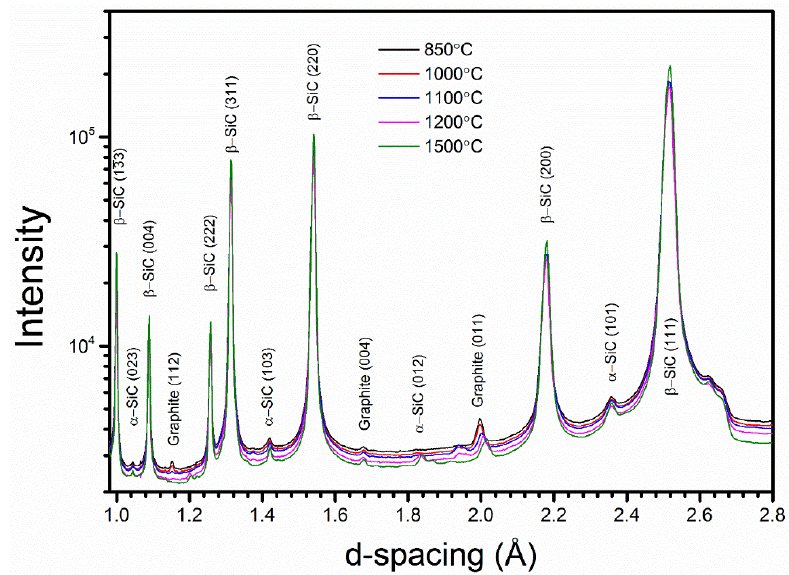
Figure 2. XRD patterns of as synthesized sample (850 °C) and samples exposed to higher temperatures showing no significant changes in the crystalline phases of the material. In all cases, the samples are mostly composed of β -SiC, less than 10 wt% α -SiC, and less than 1 wt% graphite. A reduction in the background with increased temperature is indicative of the loss of amorphous content.